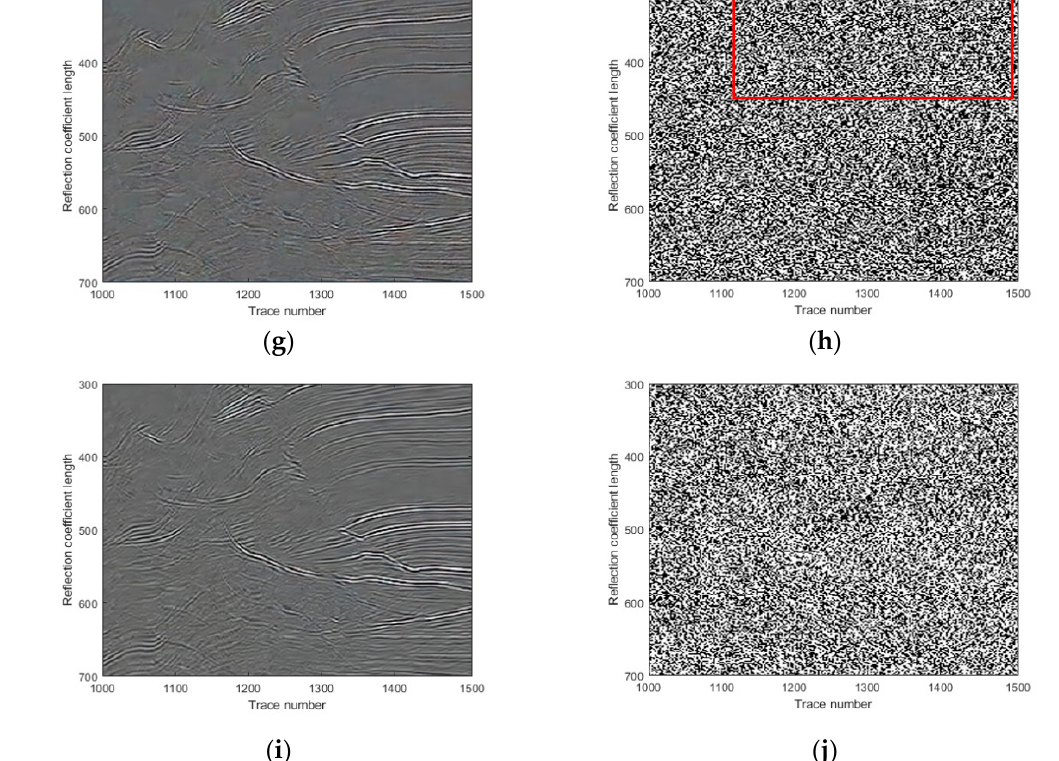
Figure 9. Denoising results of the pre-stack Marmousi2 data. The red rectangles mark the parts with distinct differences in the difference profiles among each method. ( a ) Clean data; ( b ) Noisy data; ( c ) Denoised image through the pre-trained model; ( d ) The difference profiles between noisy data ( b ) and pre-denoised data ( c ); ( e ) Denoised data through the proposed method; ( f ) The difference profiles between noisy data ( b ) and denoised data ( d ); ( g ) Denoised data through the DnCNN; ( h ) The difference profiles between noisy data ( b ) and denoised data ( g ); ( i ) Denoised data through the U-net; ( j ) The difference profiles between noisy data ( b ) and denoised data ( i ).